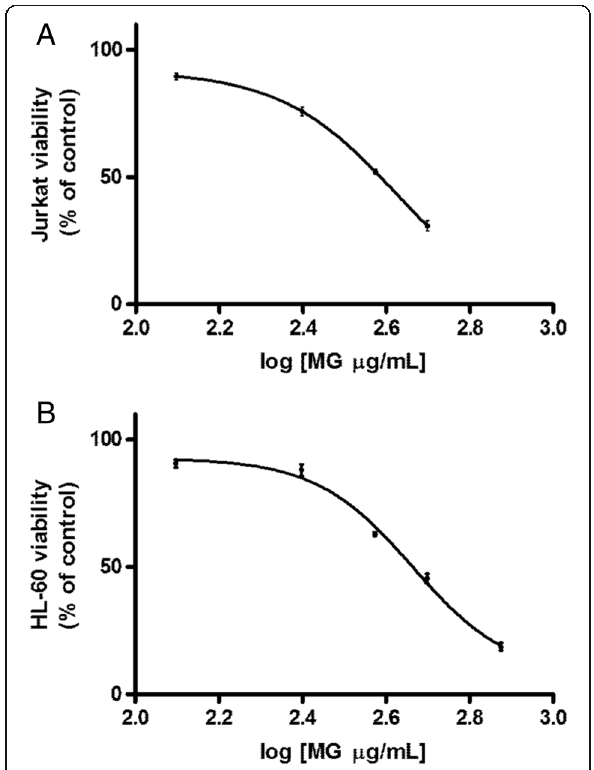
Fig. 1 Effect of MG on viability of Jurkat and HL-60 cells. Cell viability was determined as described in Methods section. IC 50 obtained by curve fitting of viable cells after 24 h treatment with MG for Jurkat cells ( a ) and HL-60 cells ( b ). Data are presented as means ± SEM of five independent